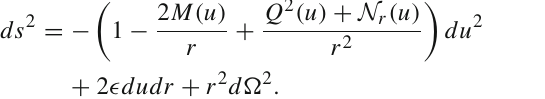
and D s versus typical values of the M ( u ) 1 2